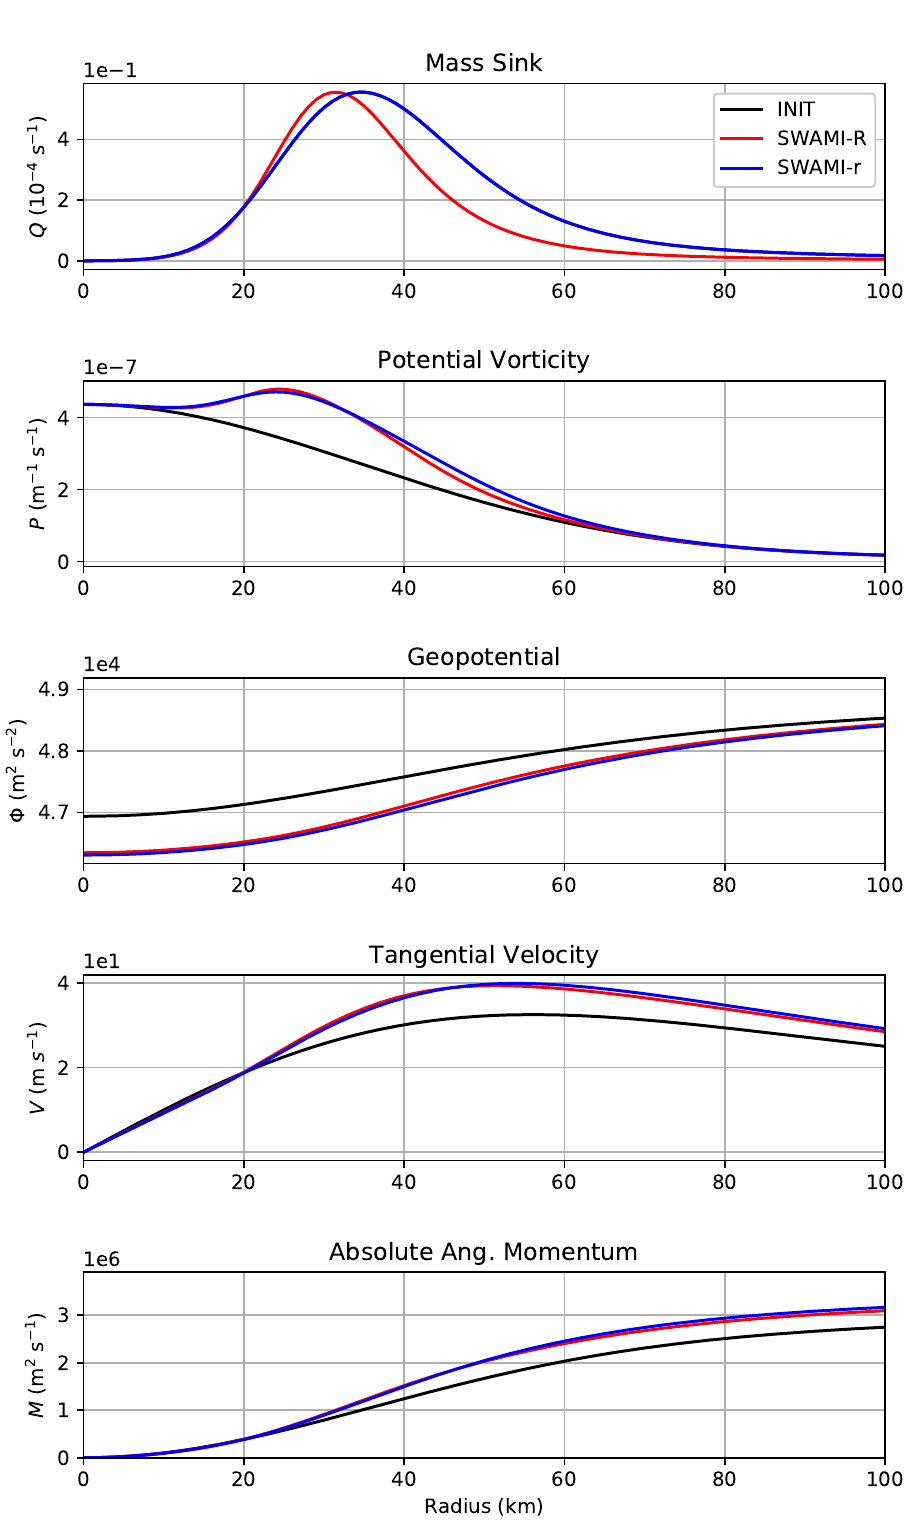
Figure 4. Same as Figure 1 but with ˙ θ = 6 K h − 1 and an MPI limiter on PV production. The MPI vortex is constructed using (17), but with Γ = Γ mpi = 24,000,000 m 2 s − 1